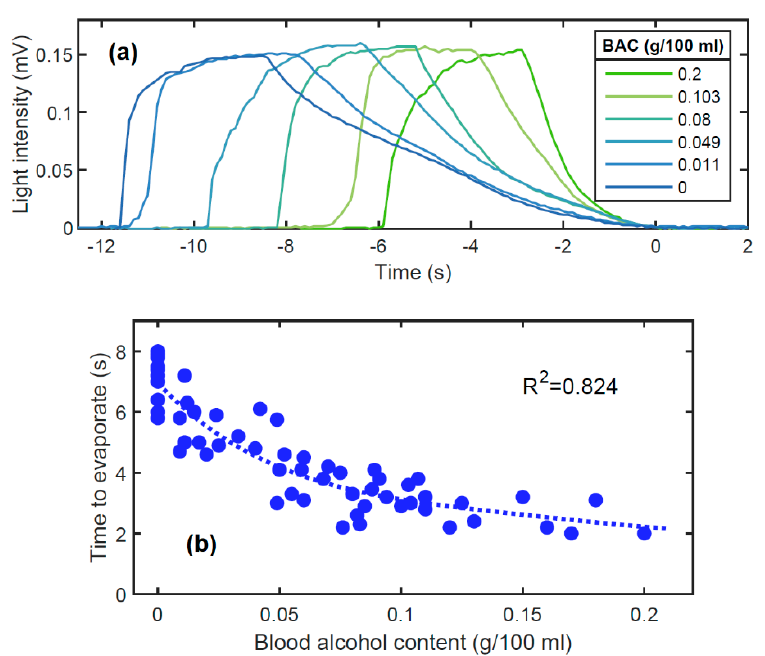
Figure 3. ( a ) Light intensity curves measured at the photodiode for different BACs. ( b ) Good correlation (R 2 = 0.824) between the breath evaporation time and the BAC in laboratory environment. A water droplet can evaporate twice as fast with 20% of alcohol compared to without alcohol, depending on humidity and ambient temperature [15]. However, the